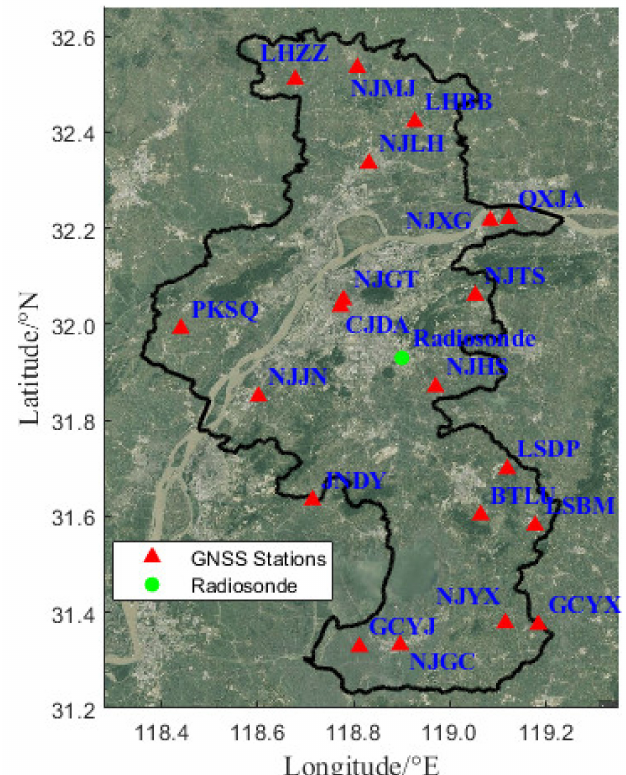
Figure 5. Experiment area, including 20 GNSS stations (red triangles) and 1 radiosonde (RS) station (green circle). Table 2. Total numbers and utilization rates of the GNSS signals for the two schemes.